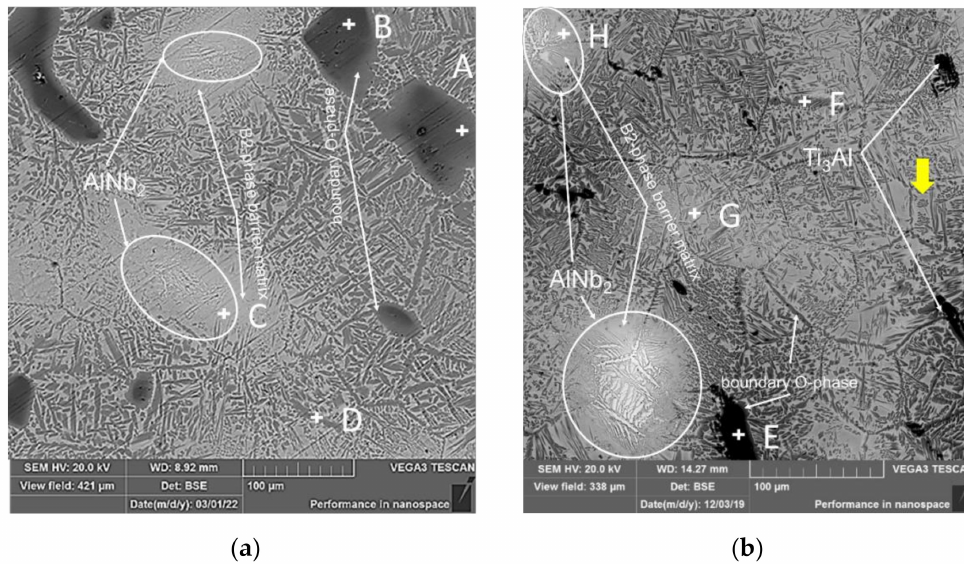
Figure 4. SEM image of samples based on Ti-Al-Nb system after SPS under the conditions of 1300 ◦ C,